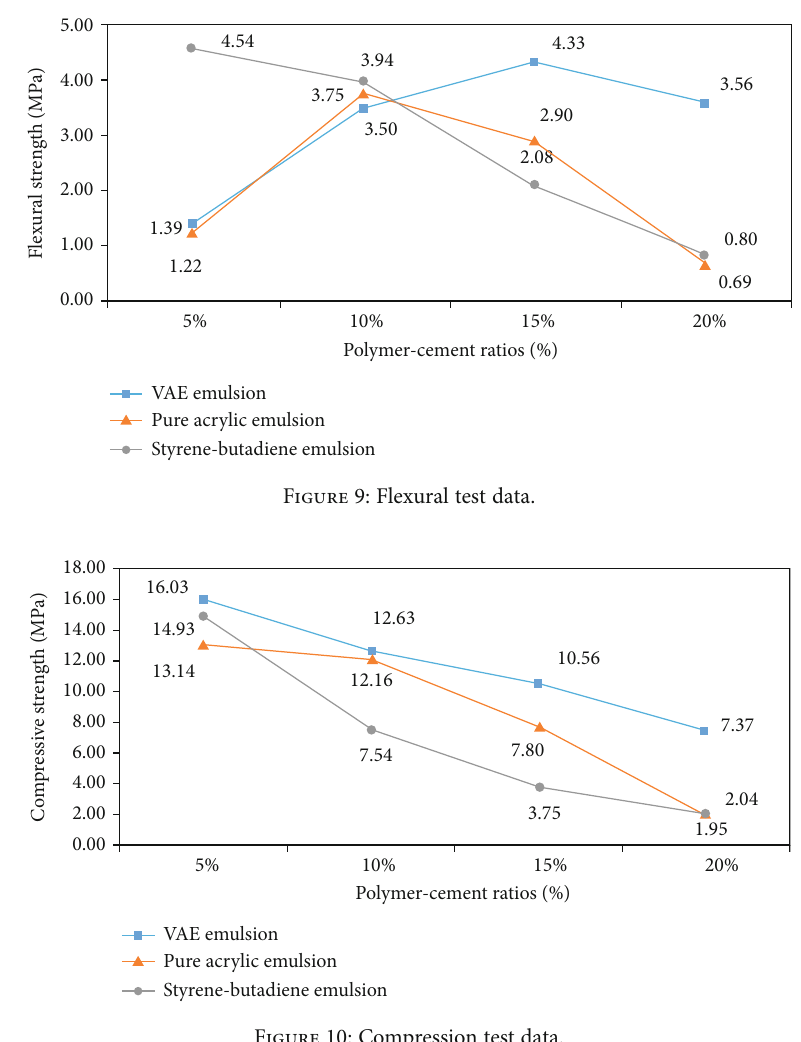
Figure 10: Compression test